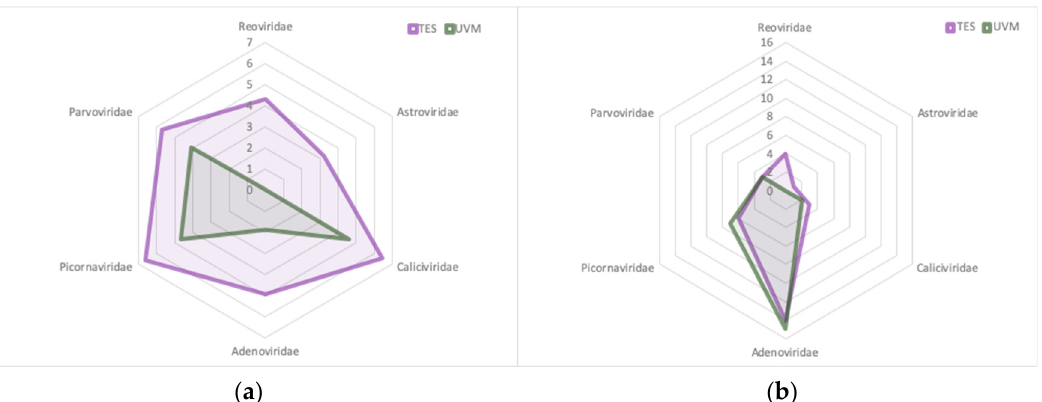
Figure 3. Comparison of the number of viral reads ( a ) and contigs ( b ) from families with members related to gastroenteritis with Target Enrichment Sequencing (TES) and Untargeted Viral Metagenomics (UVM) in the F1-3A pool. The number of reads is represented as log10.